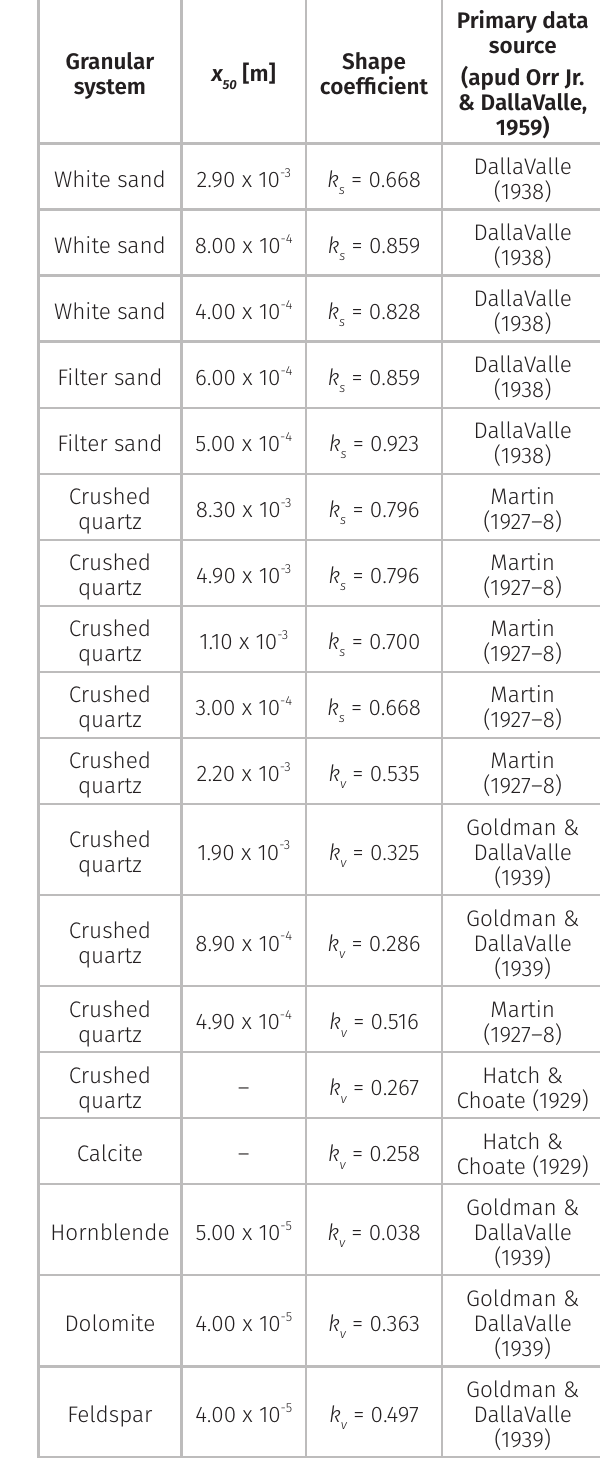
Table II. Surface and volume shape coefficient for some particulate materials (modified data from Orr